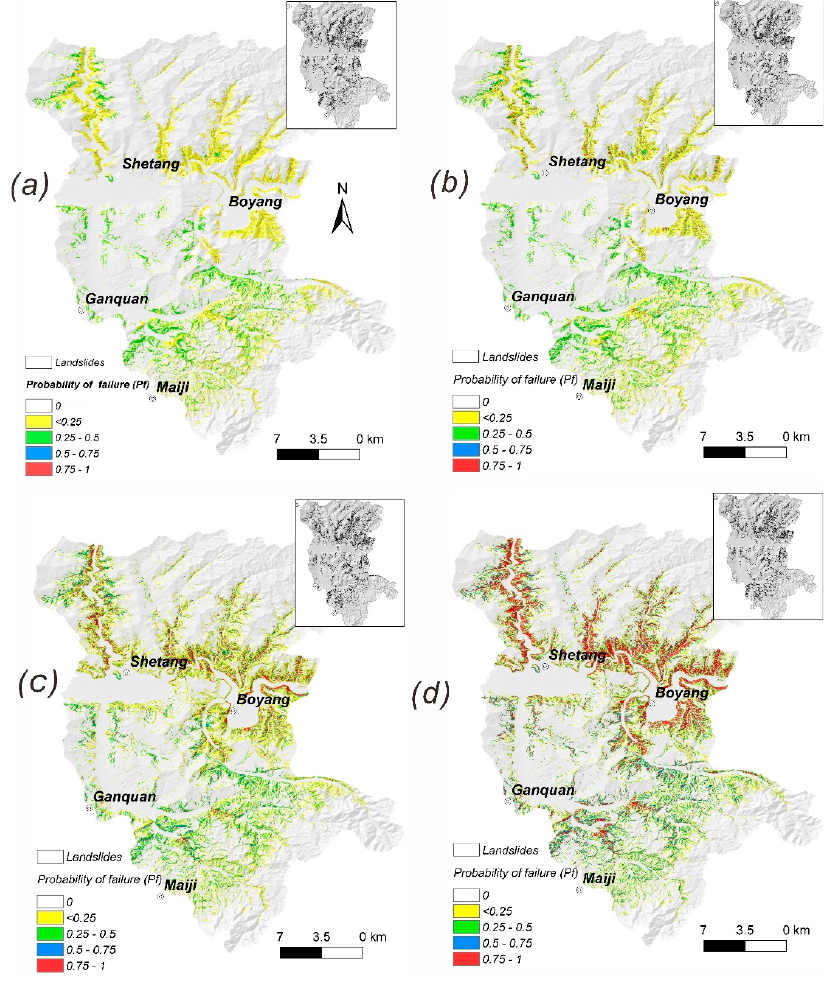
Figure 13. Prediction of probability of failure (Pf) under four rainfall events: ( a ) First rainfall event, from June 19 to 21. ( b ) Second rainfall event, from July 8 to 10. ( c ) Third rainfall event, from July 21 to 22. ( d ) Fourth rainfall event, from July 24 to 25.